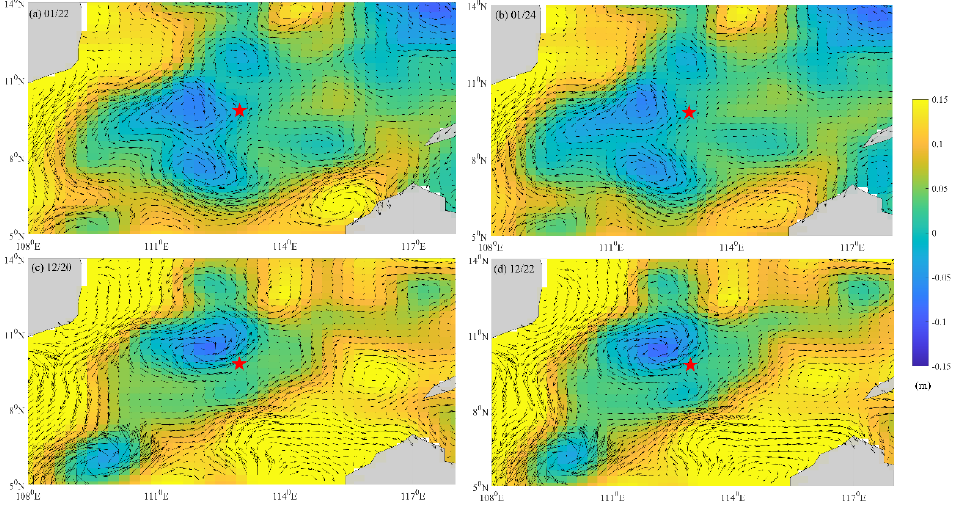
Figure 14. Sea level anomaly and the geostrophic currents anomaly from the altimeter data on 22 January 2010 ( a ), 24 January 2010 ( b ), 20 December 2010 ( c ), and 22 December 2010 ( d ). The observation site is marked by the red star.